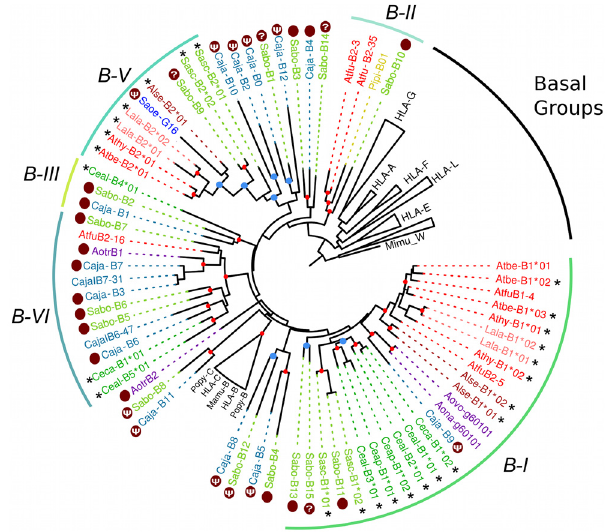
Fig 4. Bayesian phylogenetic tree based on exons 4 – 8 of Platyrrhini MHC-B sequences. Sequences marked with an asterisk ( * ) are cDNAs from this work, whereas those marked with a dark red dot are genomic sequences used to assign cDNAs to a given lineage. Red dots on the branching points represent a support with a posterior probability > 0.9, and light blue dots represent a support with a posterior probability between 0.7 and 0.9. Lineages and clusters are indicated at the periphery of the tree. Caja, Callithrix jacchus ; Sabo, Saimiri boliviensis ; Sasc, Saimiri sciureus ; Pipi, Pithecia pithecia ; Athy, Ateles hybridus ; Atbe,